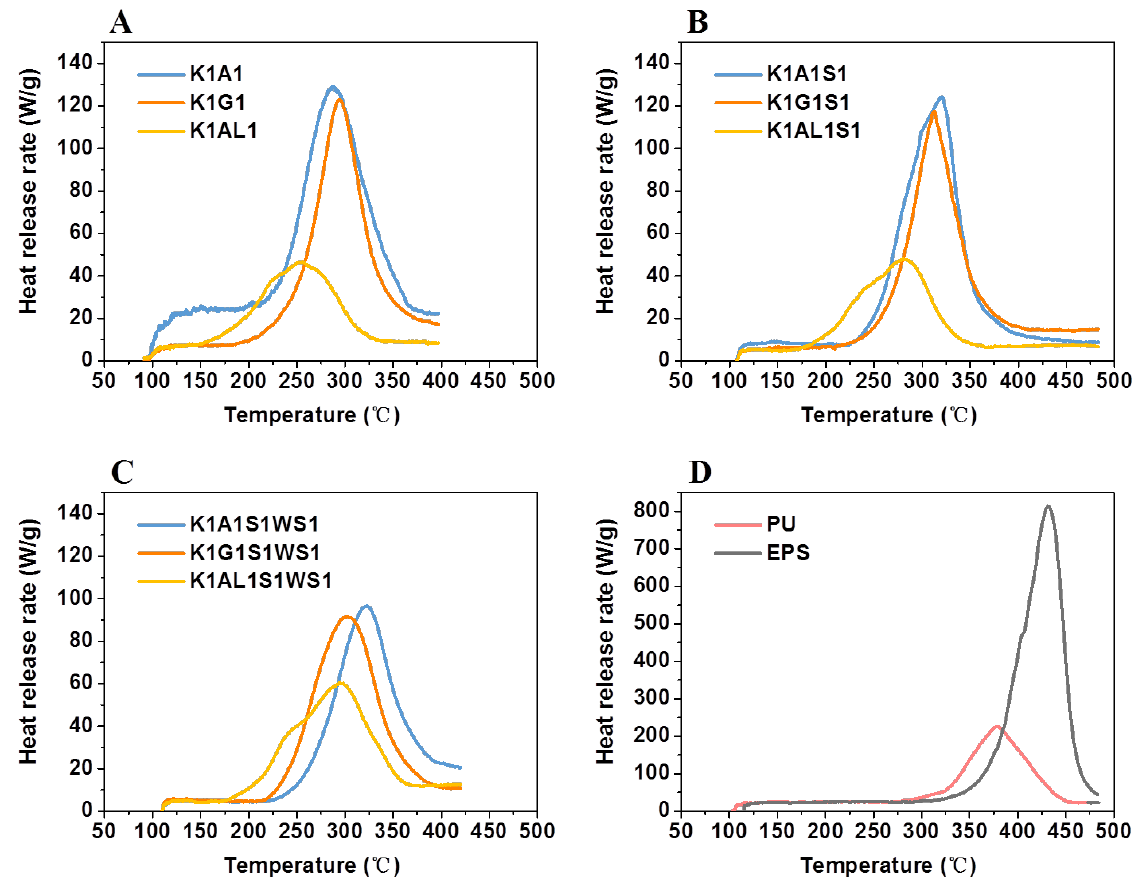
Figure 3. Heat release rate (HRR) curves of binary aerogels ( A ); ternary aerogels ( B ); quaternary aerogels ( C ); PU and EPS ( D ).